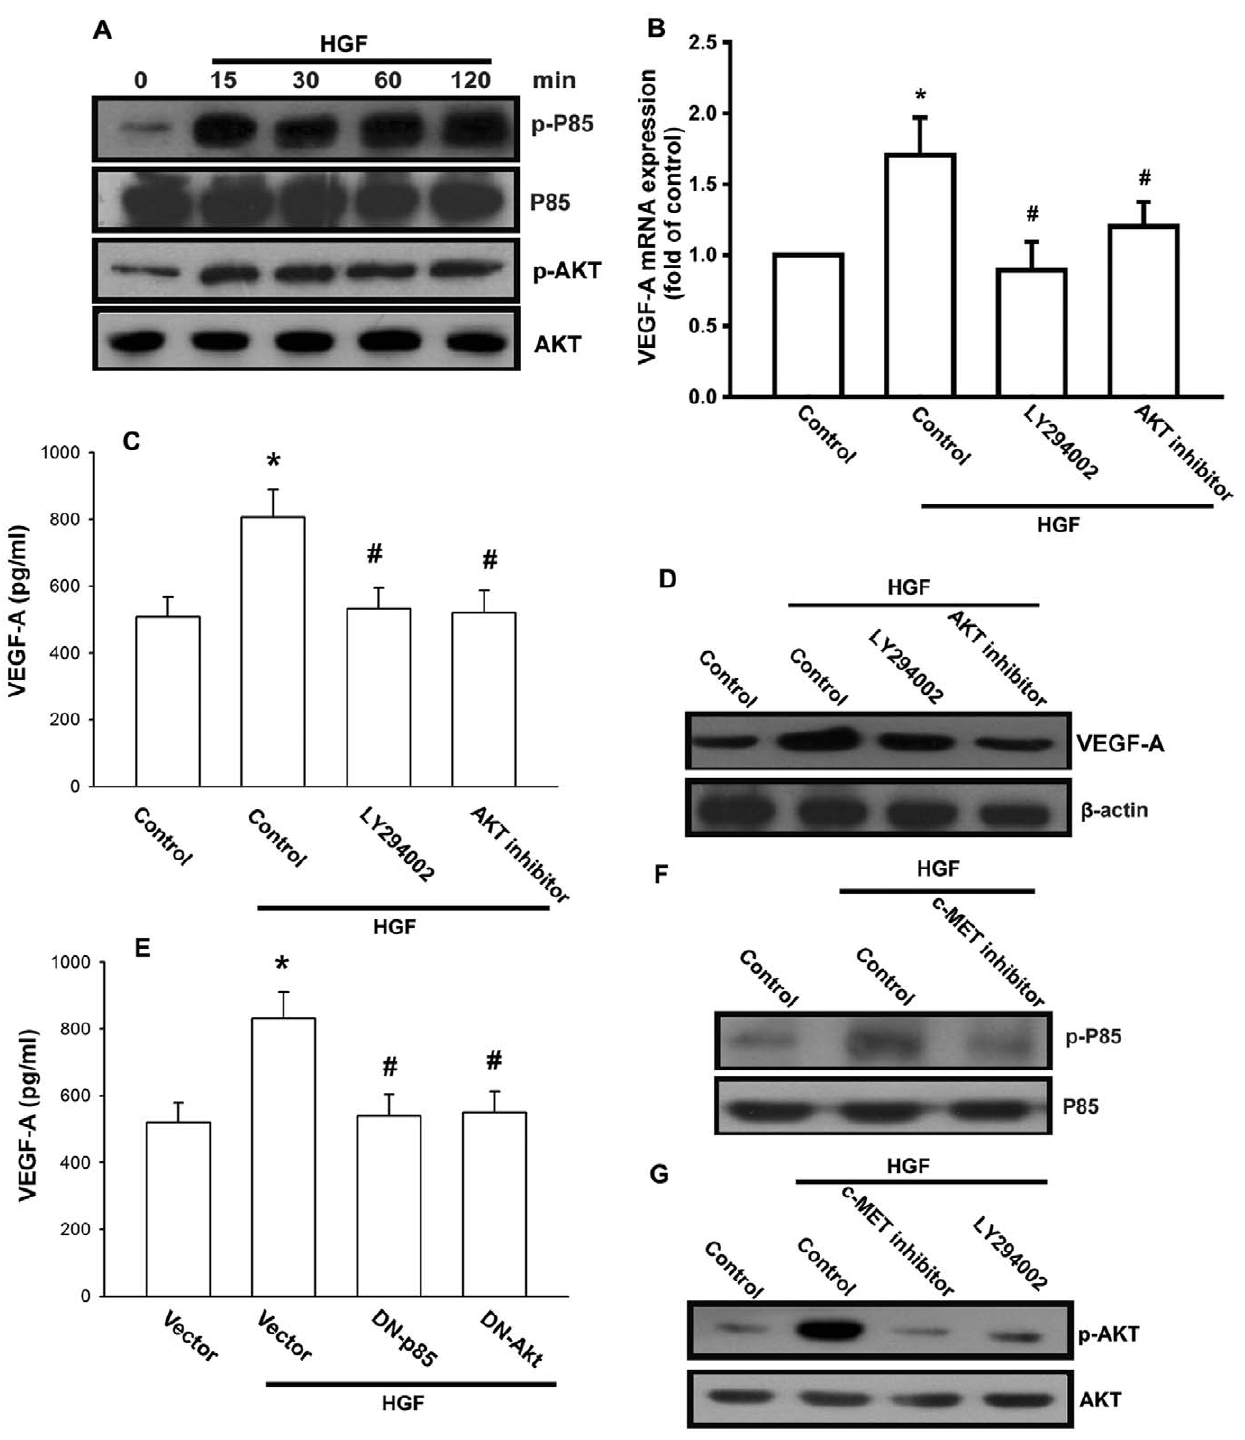
Figure 3. The PI3K/Akt signaling pathway is activated in response to HGF treatment of synovial fibroblasts. (A) OASFs were incubated with HGF for indicated time intervals, and p85 and Akt phosphorylation was examined by Western blotting. (B–D) OASFs were pretreated for 30 min with Ly294002 (10 m M) or Akt inhibitor (10 m M) followed by treatment with HGF for 24 h, the VEGF-A expression was examined by qPCR, Western blotting, and ELISA. (E) OASFs were transfected with p85 or Akt mutant followed by stimulation with HGF for 24 h, the VEGF-A expression was examined by ELISA. OASFs were pretreated for 30 min with c-Met inhibitor (F) or c-Met inhibitor and Ly294002 for 30 min (G) followed by stimulation with HGF for 15 min, and p85 and Akt phosphorylation was determined by Western blotting. Results are expressed as the mean 6 S.E. *, p , 0.05 compared with control; # , p , 0.05 compared with HGF-treated group.